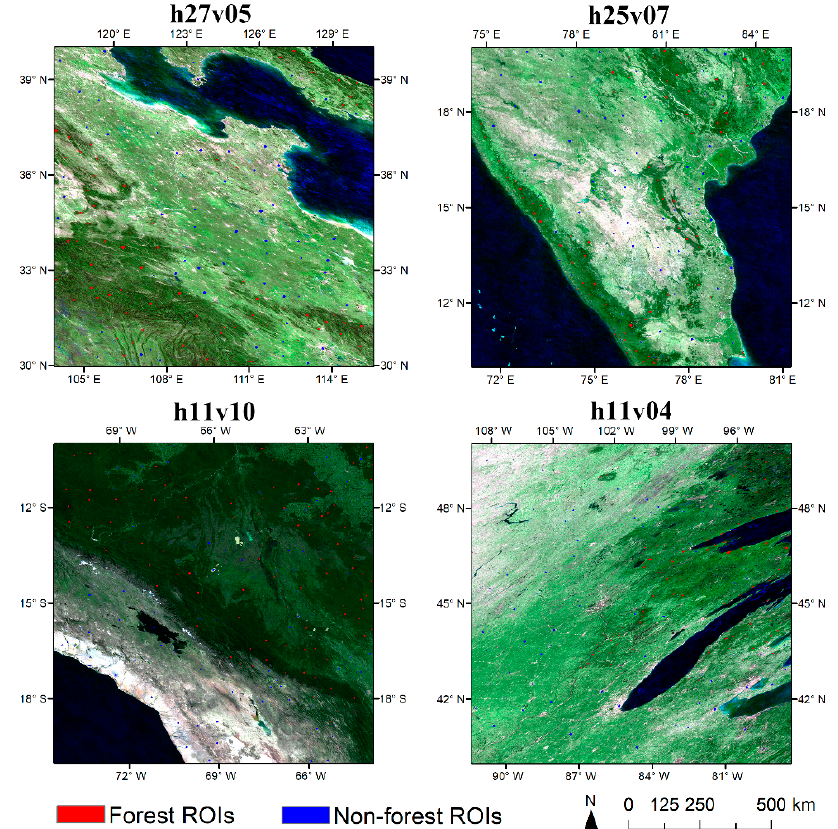
Figure 1. Study area of four MODIS tiles (h27v05, h25v07, h11v10 and h11v04) and spatial distribution of reference regions of interest (ROIs) used for accuracy assessment. The true-color images show the greenest status of land surface throughout the year in 2010 of four tiles, which were obtained through the minimum red-band composition. For the RGB images, dark green represents forests, light green shows other vegetated area and gray is non-vegetated area.